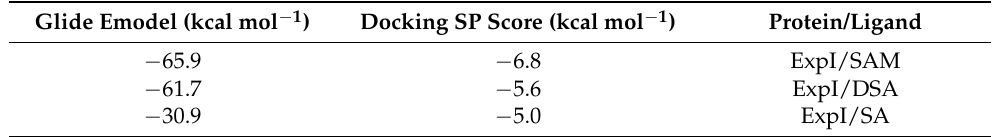
Table 1. Results from studies of the docking of SAM, DSA and SA to ExpI.